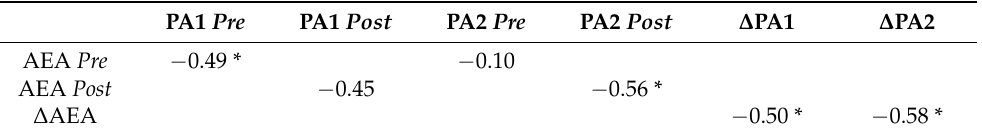
Note: Pearson correlation coefficients are reported.